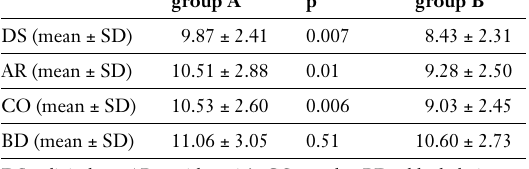
Subtle neuropsycho- logical deficits.